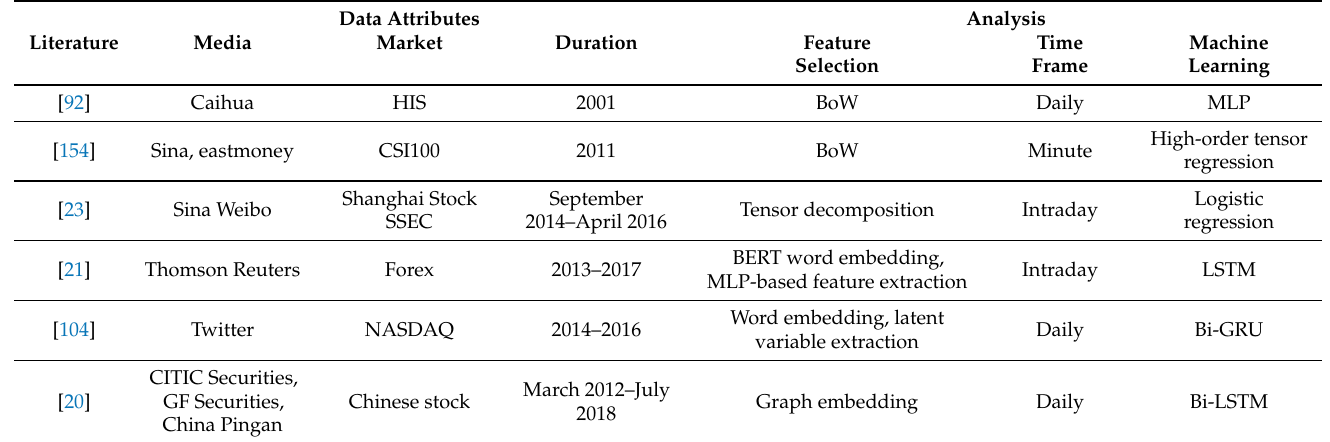
Table 5. Detailed trait of predictive models based on chaotic data.